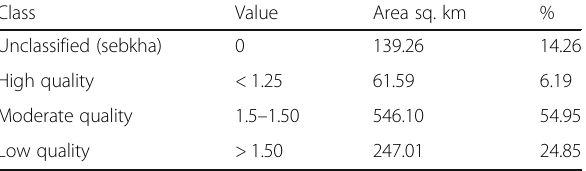
Table 12 Spatial distribution of management quality